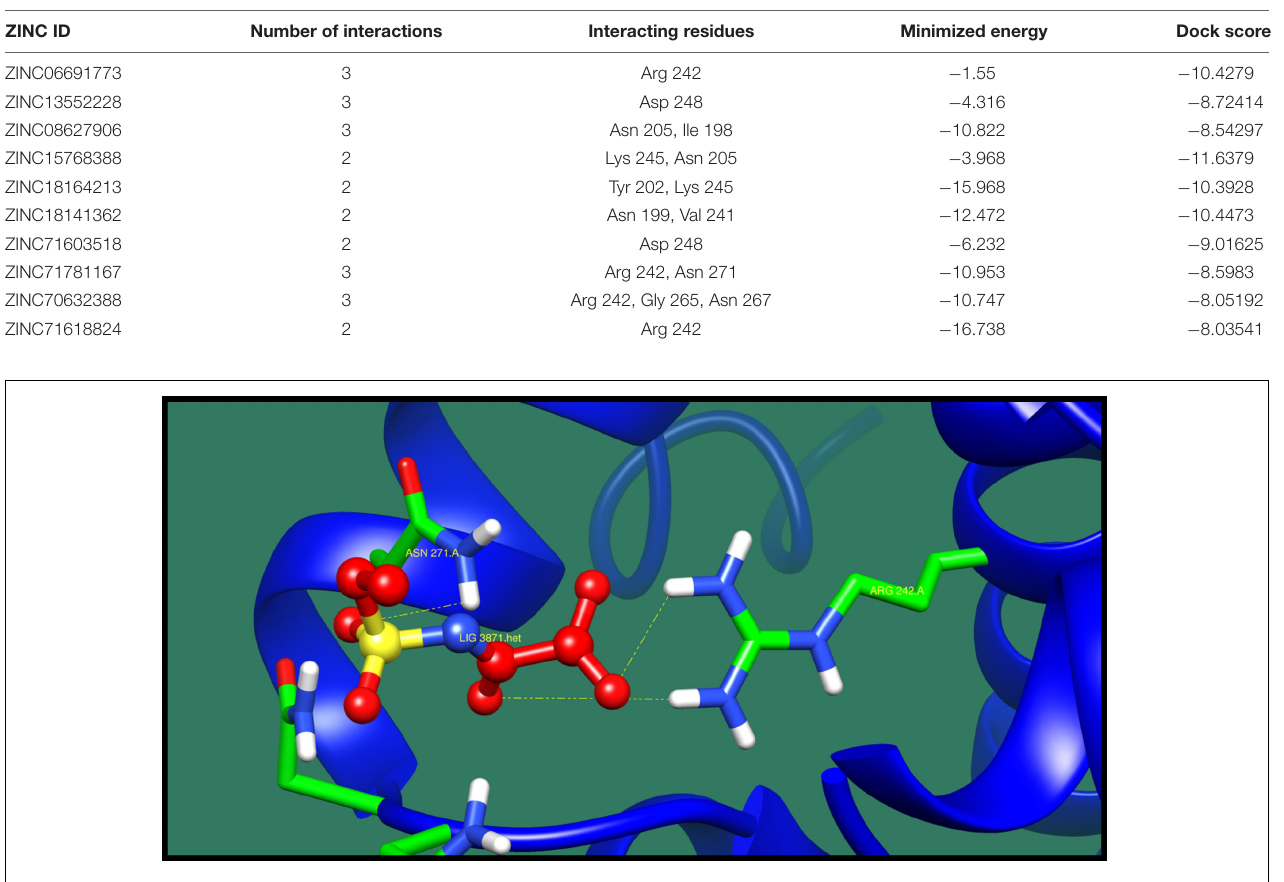
FIGURE 9 | Interaction of AraC family transcriptional regulator with ZINC71781167 (colored in red). The interacting residues (green) are shown making bonding (dotted lines) with the ligand.